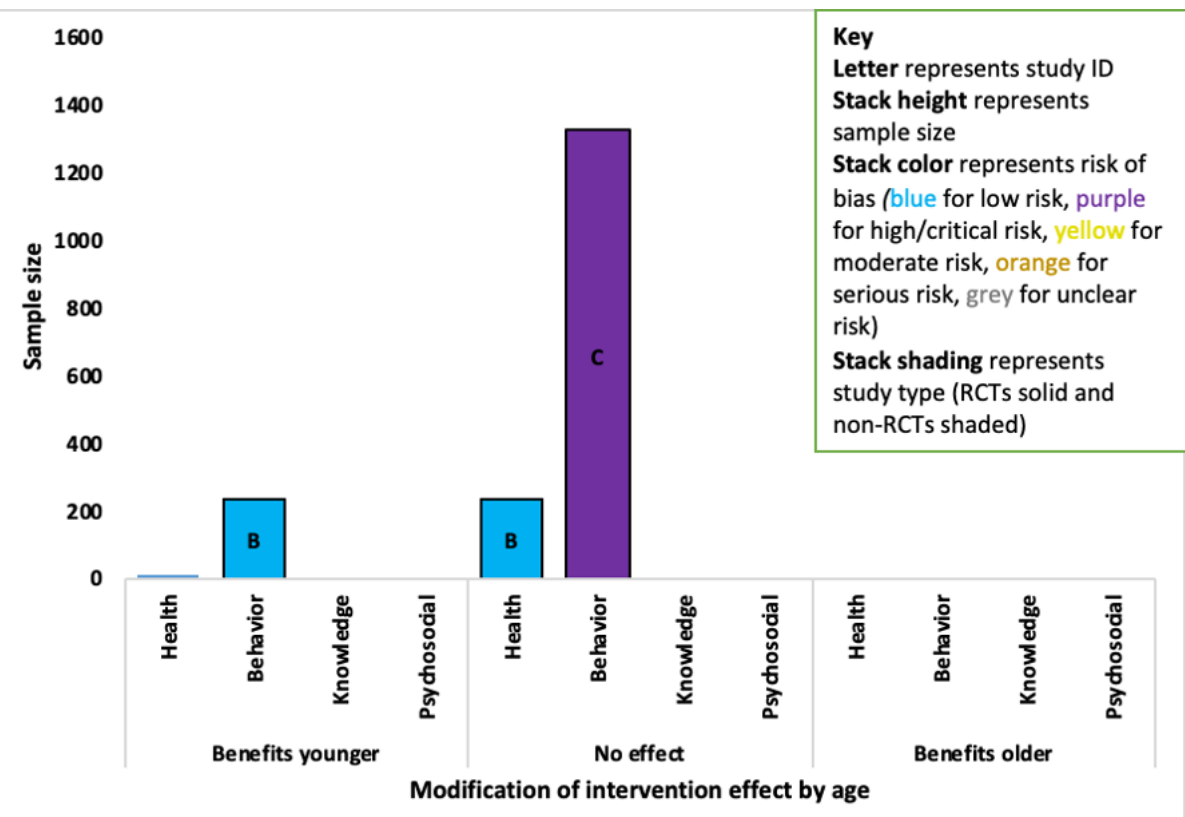
Figure 4. Adapted Harvest plot with evidence for the modification of intervention effect by increasing age for chronic obstructive pulmonary disorder studies. RCT: randomized controlled